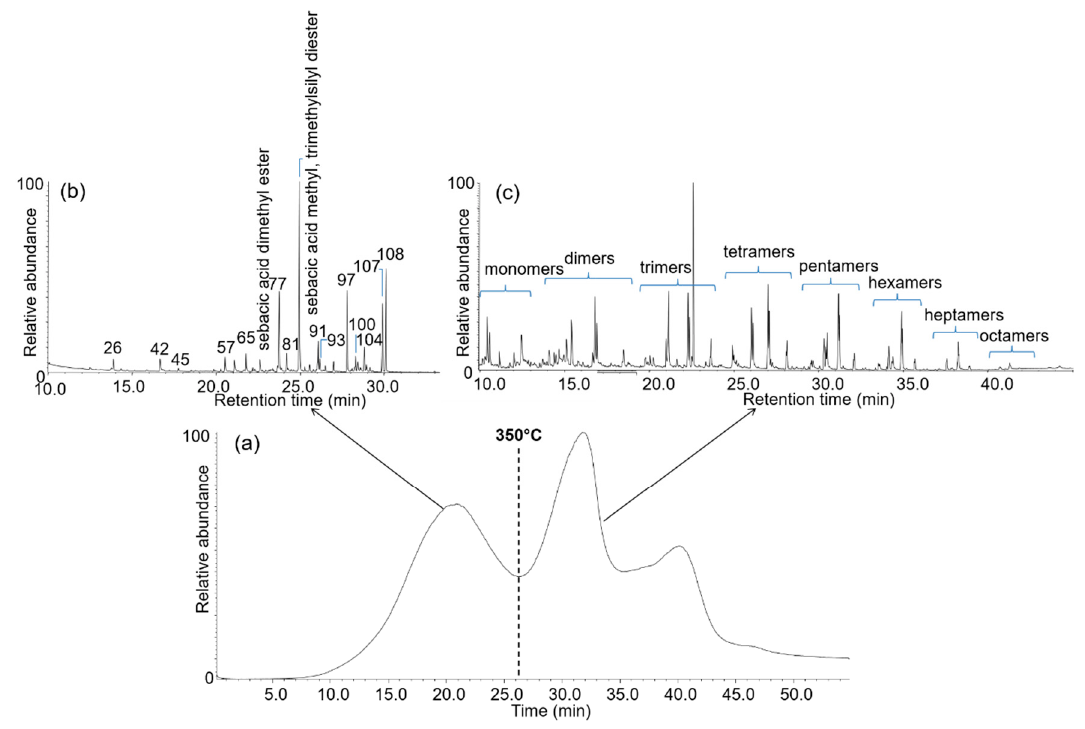
Figure 9. TIT of sample Ly-A1 from the Lyon2 ship obtained by EGA-MS ( a ) and pyrolytic profiles obtained by double-shot Py(HMDS)-GC/MS of the same sample: first shot at 320 °C ( b ) and second shot at 600 °C ( c ), showing the separation between wood and PEG pyrolysis products. Peak labelling refers to Table 3.